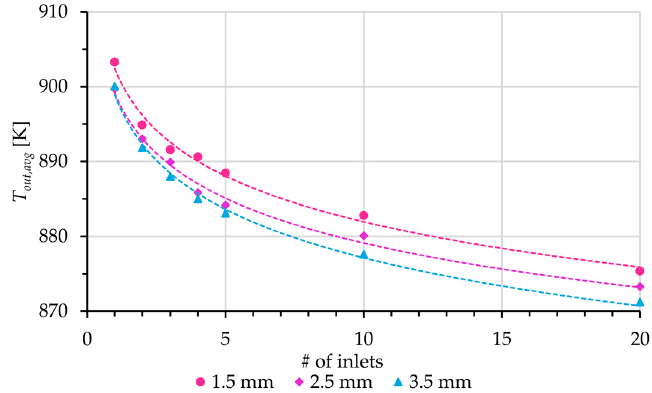
Figure 16. Average outlet temperatures for each simulated geometry.